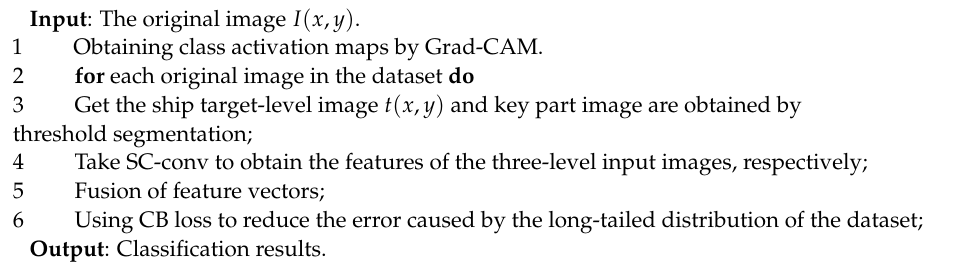
Figure 2. Comparison of midship images in different ships. ( a , b ) are container ships; ( c ) is a nuclear- powered aircraft carrier; ( d – f ) are guided missile frigates, guided missile destroyers and guided missile cruisers, respectively; ( a , b ) show that the midships of ships of the same type are highly similar; ( c – f ) show that the midship parts of different types of ships are quite different. Algorithm 1. The recognition process of fine-grained optical remote sensing